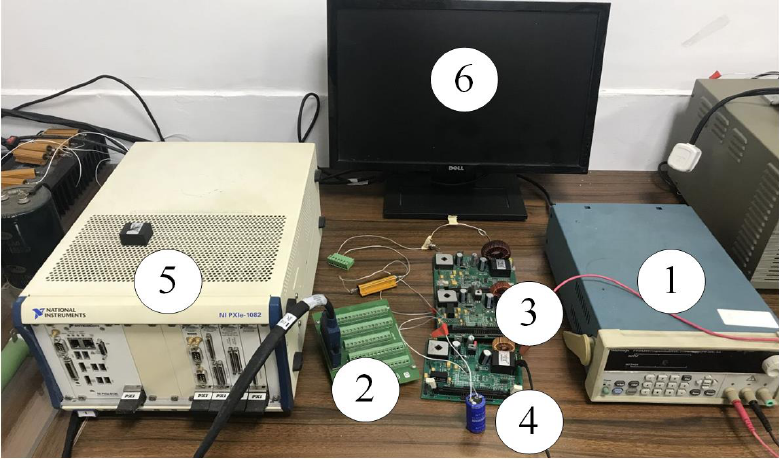
Figure 5. The hardware design: (1) power source; (2) measurement board; (3) three chargers; (4) ultracapacitor; (5) PCI extensions for Instrumentation (PXI) platform; (6)